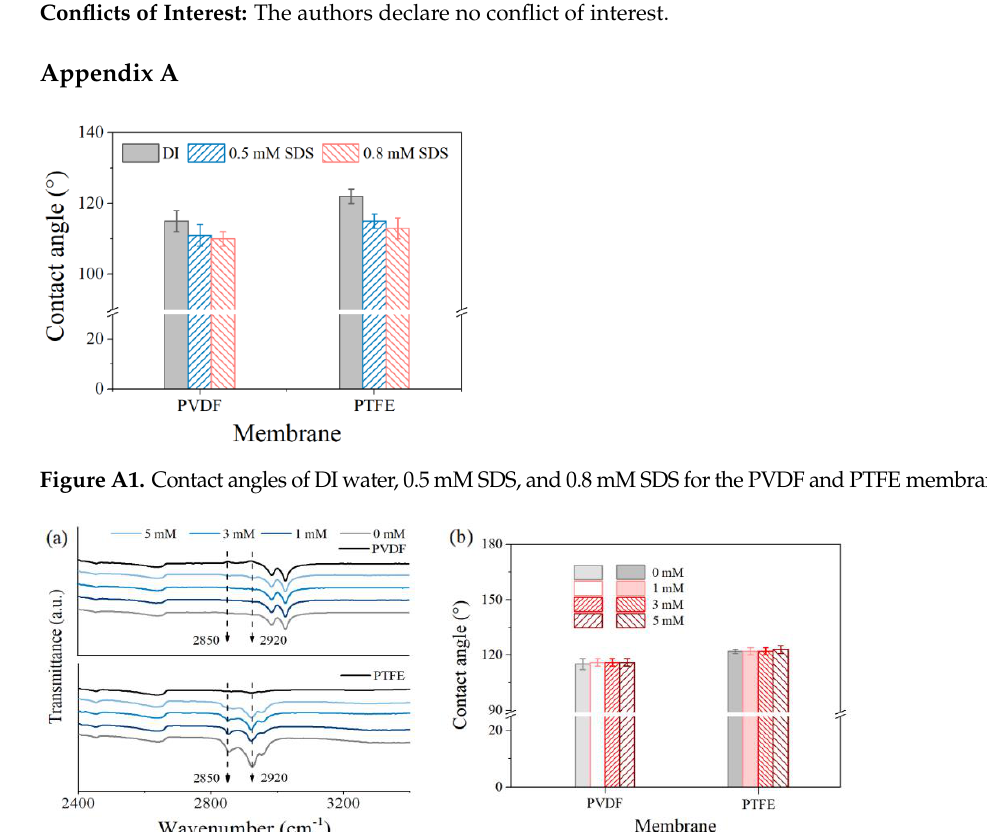
Figure A2. FTIR spectra of the pristine and used membranes ( a ), water contact angle for the testing in MD with different concentrations of PDS solution feeds according to Figure 4 ( b ).